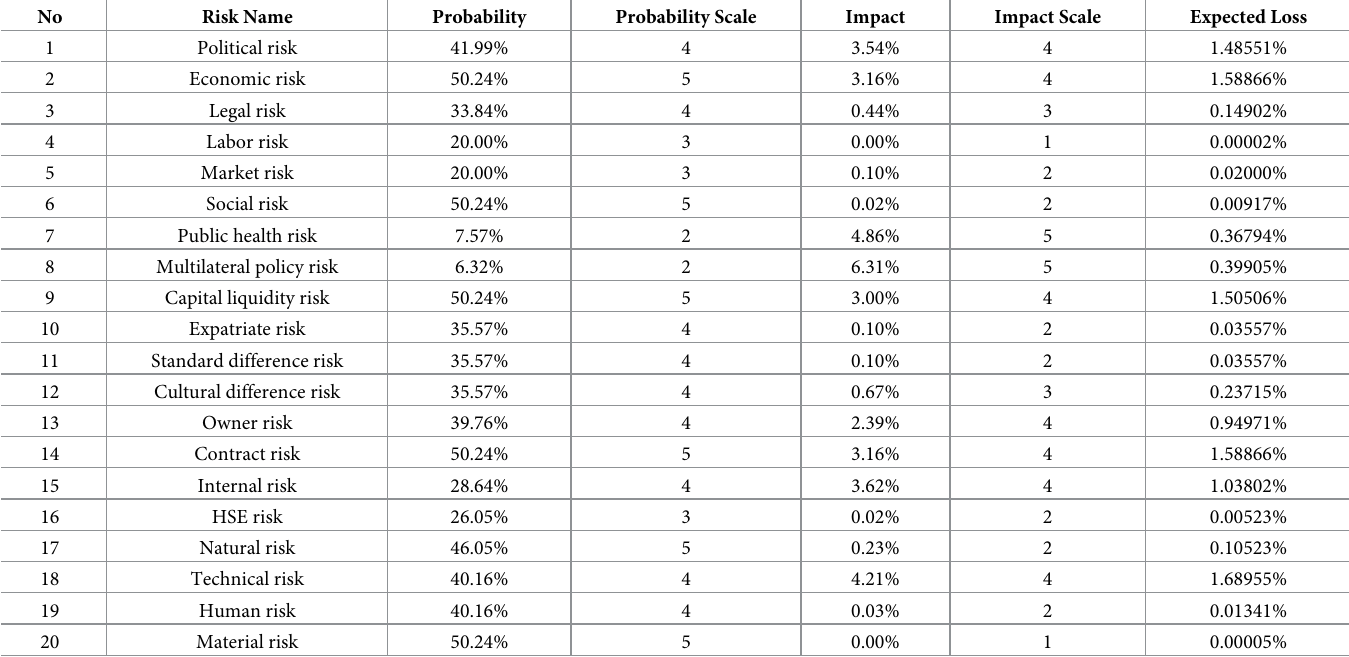
Table 5. Analysis results of individual project risks for the target